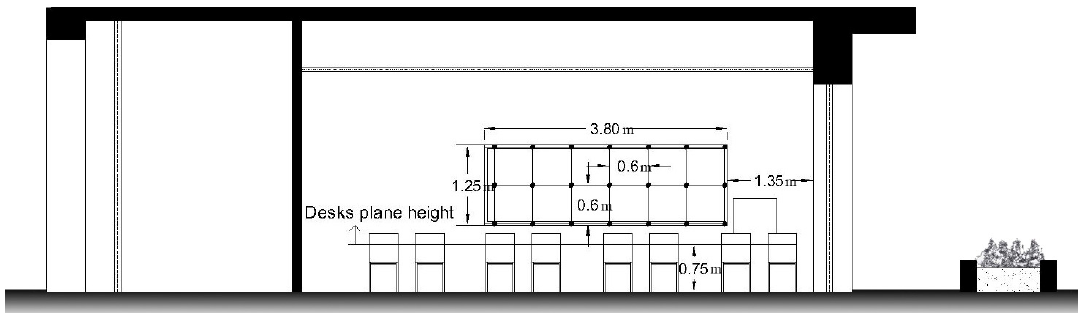
Figure 6. Elevation of the board wall showing vertical sensors grid.